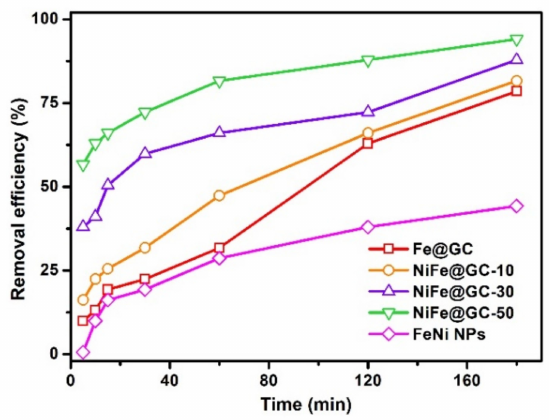
Figure 3. The profiles of TCP removal by NiFe@GC with different Ni/Fe ratios and FeNi NPs. (Experimental conditions: TCP = 30 mg L − 1 , pH = 3.0, dosage = 1.0 g L − 1 , T = 298.15 K).